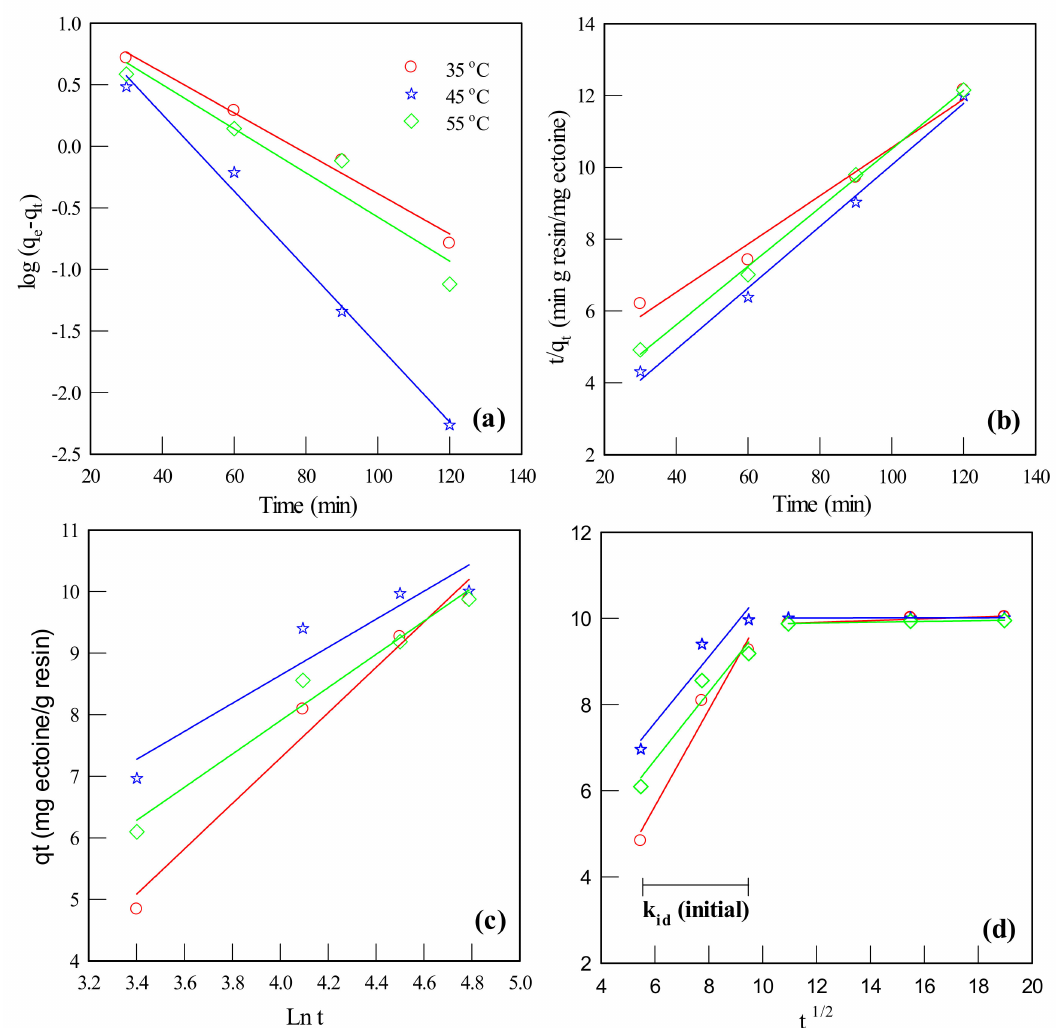
Figure 7. Regression analysis of the adsorption of ectoine by the ( a ) pseudo-first-order equation, ( b ) pseudo-second-order equation, ( c ) Elovich equation, and ( d ) intraparticle diffusion model. Table 4. Kinetic parameters for ectoine ions using Dowex ® HCR-S as the adsorbent.